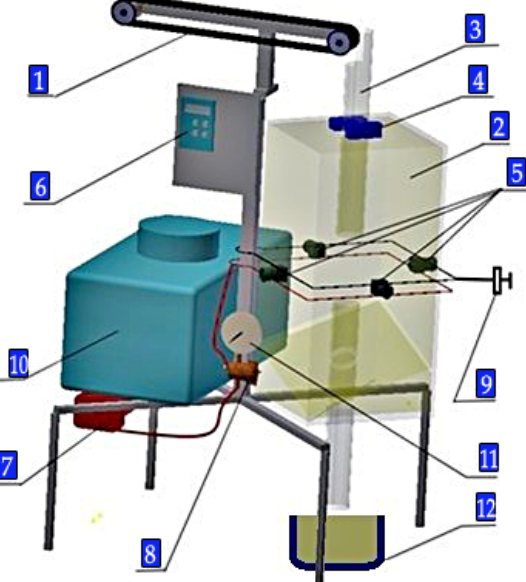
Figure 1. A laboratory facility for assessment of the degree of coverage by means of the weight